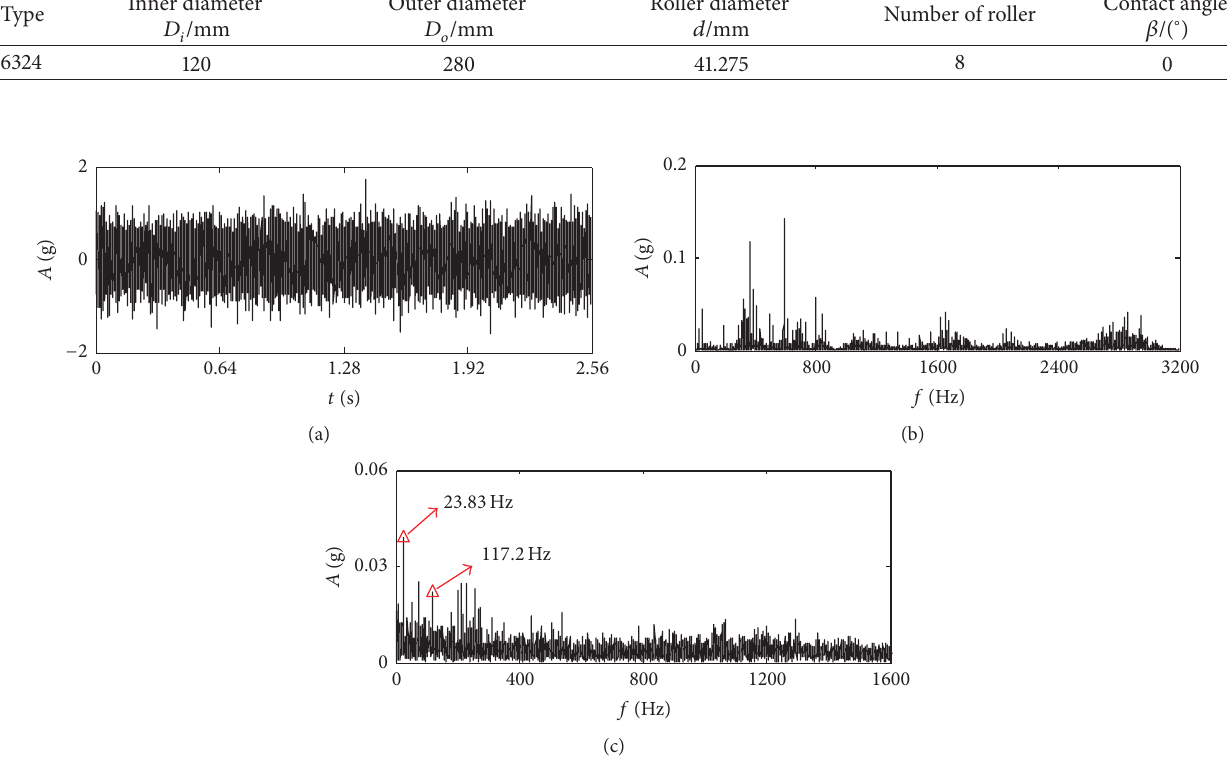
Figure 10: Vibration signal of bearing: (a) the time waveform; (b) the frequency spectrum; (c) the envelop spectrum.